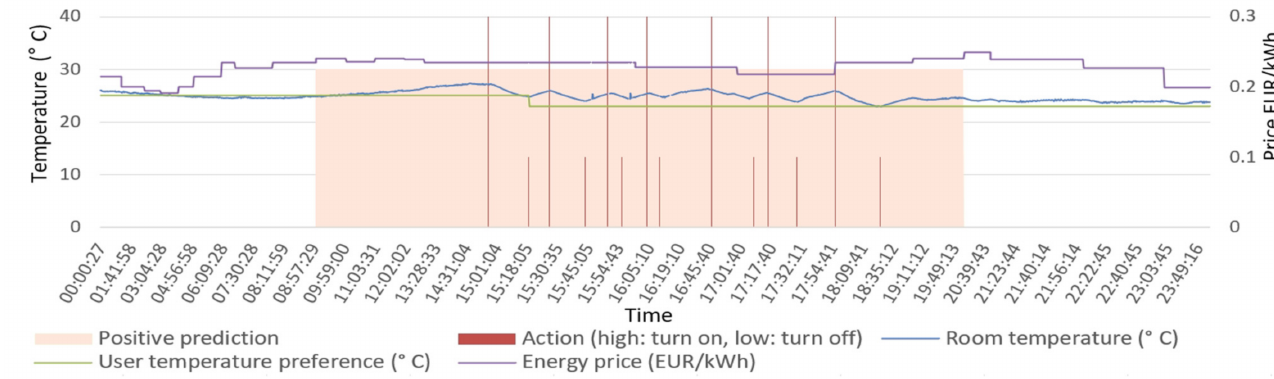
Figure 6. HVAC control signals for N101 during 27 August